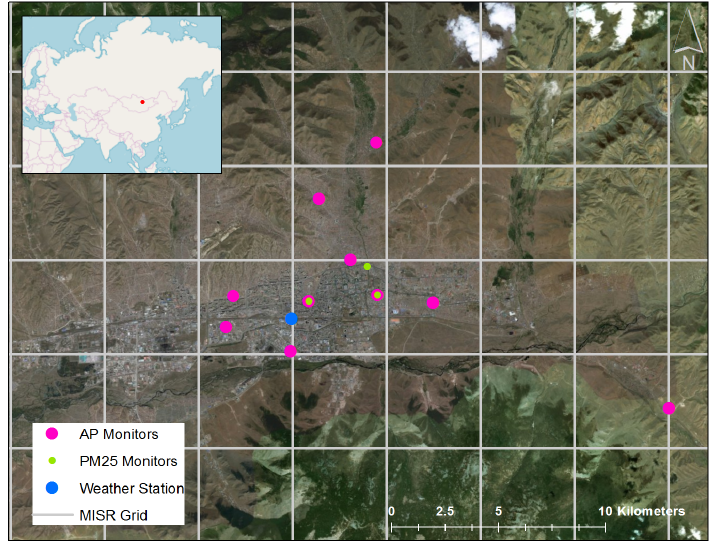
Figure 1. Ulaanbaatar, Mongolia study region showing gaseous and particulate air pollution monitoring stations, weather station, and representative 4.4 km